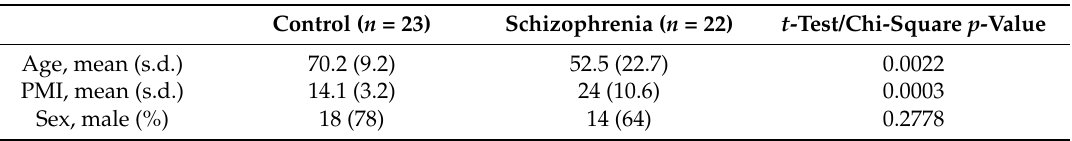
Table 1. Summary of demographic